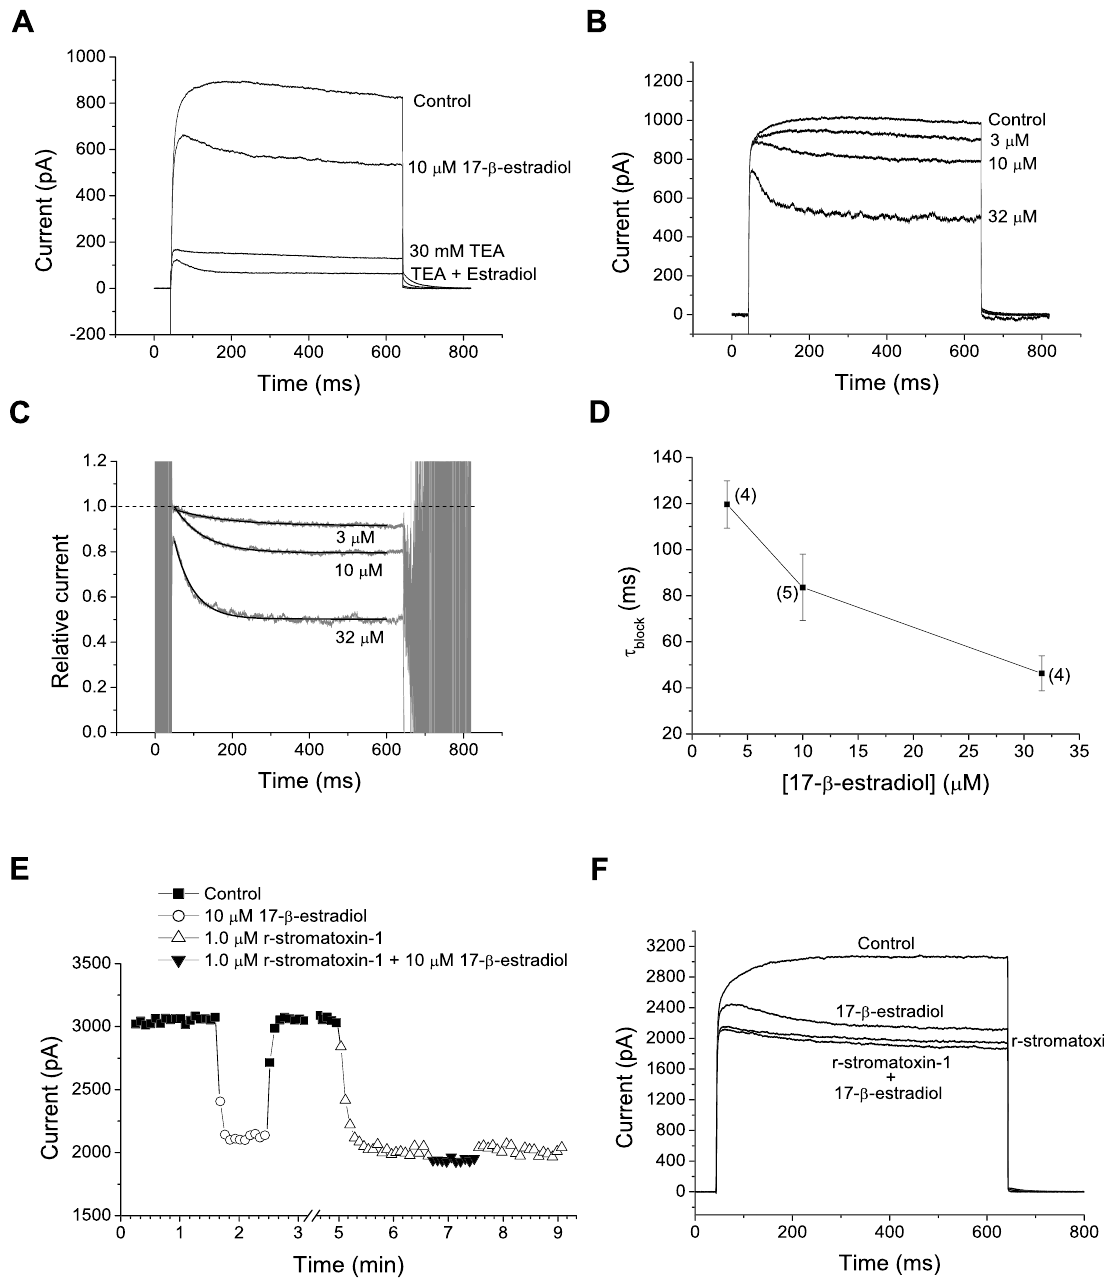
Figure 3. Sensitivity to blockers and concentration-dependent rate of current decline. A, currents (averages of 10 traces) evoked by a voltage step from 2 74 mV to + 6 mV in solutions as indicated. Note that 30 mM TEA blocked a major fraction of the voltage-activated K + current without leaving any significant transient current remaining. Note also that the blocking effects of TEA and 17- b -estradiol were overlapping. B, currents evoked by voltage steps from 2 74mV to + 26 mV, in control solution and in the indicated concentrations of 17- b -estradiol. Note the faster current decline and the larger block with increasing concentration of 17- b -estradiol. C, ratio of current ( grey ) in 17- b -estradiol to that in control solution, to show the time course of current inhibition. The traces were well fitted by exponential functions with time constants 134ms ( top ), 75ms ( middle ) and 49 ms ( bottom ), shown as superimposed black lines. Computed from the traces shown in B. D, dependence of time constant of relative current, as in C, on concentration of 17- b -estradiol. Mean 6 S.E.M. for the number of neurons indicated. Voltage steps to + 26mV from 2 74 mV. E-F, overlapping block by estradiol and r-stromatoxin-1. E, time-course of block of the K + current (mean current 590–600 ms after a voltage step from 2 74 to + 26 mV) by estradiol, r-stromatoxin-1 and a combination of these substances, as indicated. F, K + currents (averages of 10 traces) evoked by voltage steps from 2 74 to + 26 mV. Concentration of blockers as in E. Note the lack of effect of estradiol in the presence of r-stromatoxin-1. Data in E and F from the same neuron.